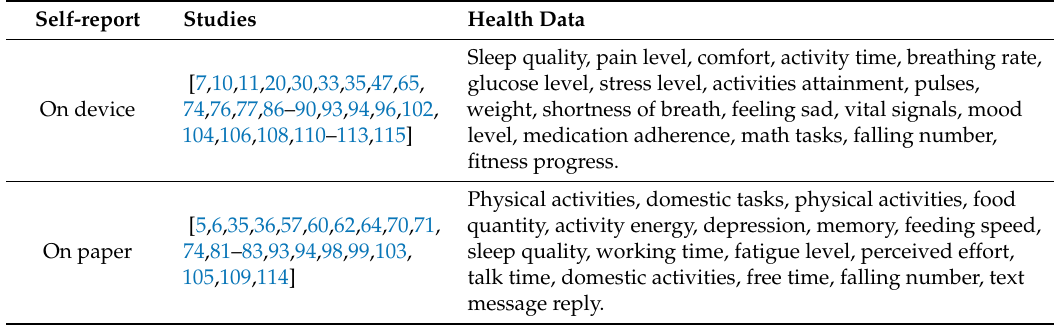
Table 4. Features of self-reporting for older